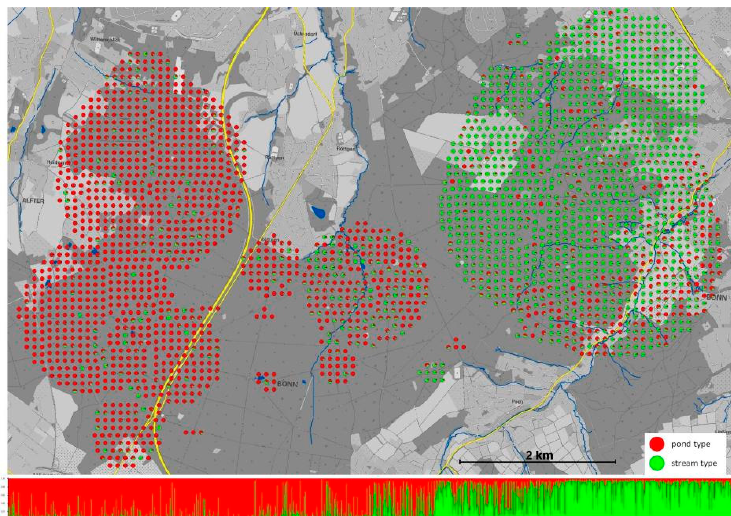
Figure 3. The adaptive divergence of the Kottenforst fire salamander population according to pond- and stream larval habitat. The fine-scale spatial distribution of 2653 genotypes representing individual salamander larvae sampled from pond and stream habitats across the Kottenforst. Each dot represents a single individual displaying as a pie chart the percentage assignment assuming two genetic clusters (K = 2). The bar plot composed of individual genotypes (each line represents a single larva) shows the corresponding assignment as represented by the pie charts from west to east across the Kottenforst. (From Hendrix et al. [334]).